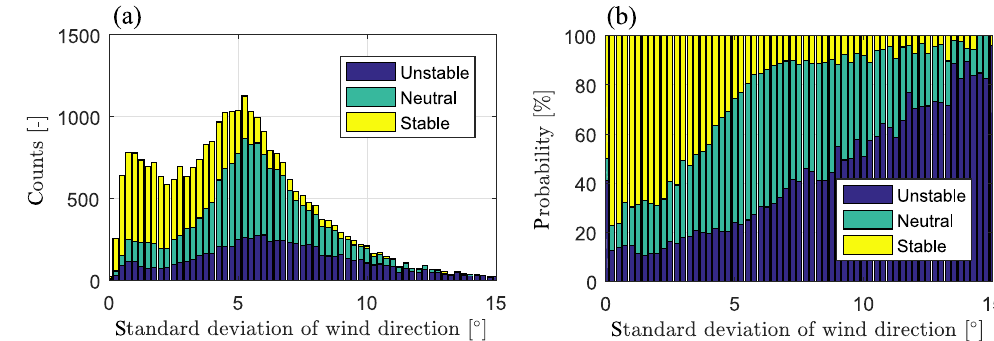
Figure 14. (a) Histogram of 5min standard deviations of the wind direction separated in the categories of atmospheric stabilities stable, neutral and unstable. (b) Normalized histogram of the data.